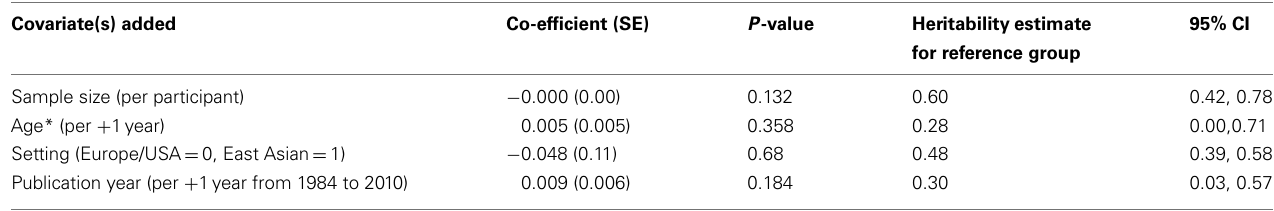
Table 5 | Results of meta-regression analyses to identify study-level demographic or methodological factors associated with reported BMI heritability estimates in family